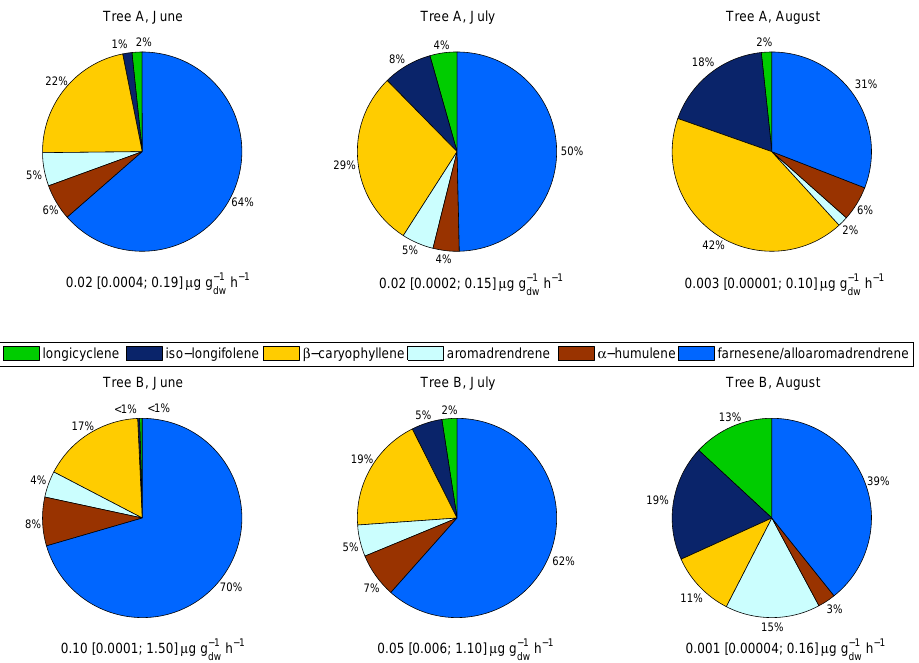
Fig. 4. Measured emission spectra of sesquiterpenes from the two Larix cajanderi trees during the measurement campaigns. Given below each pie chart are the monthly median and 5th and 95th percentile values of the total sesquiterpene emission